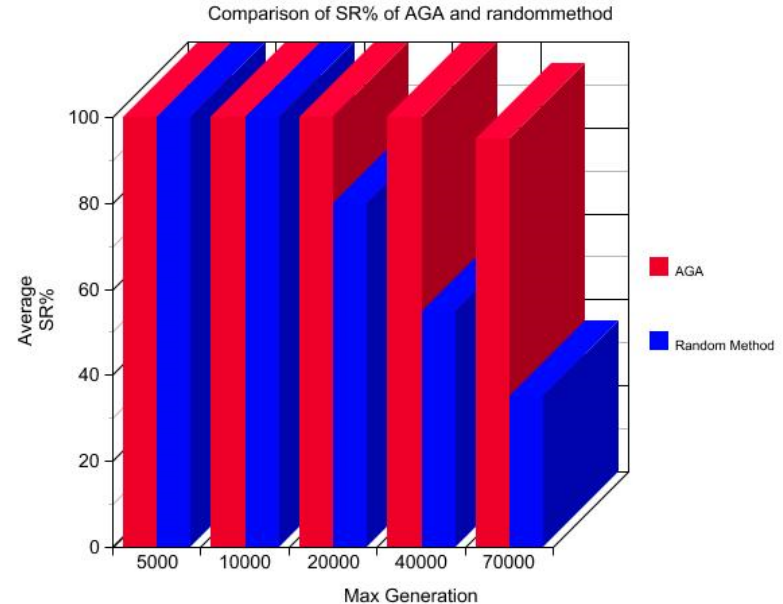
Figure 6. Comparison of success rate of AGA and random method.